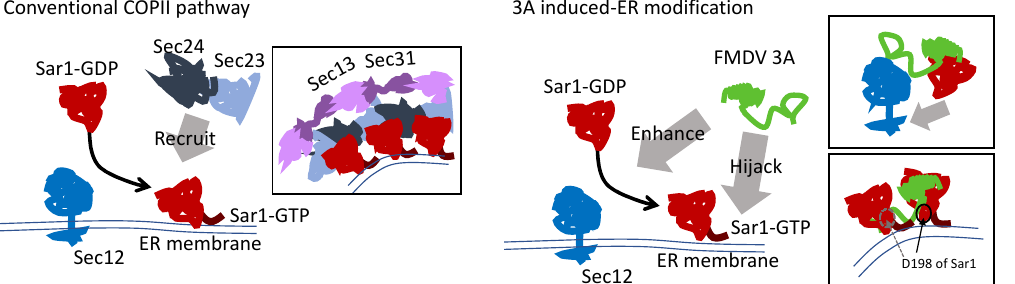
Figure 7. In the conventional COPII pathway, after activation by Sec12, Sar1 attaches to the ER membrane with the N-terminus, further recruiting the inner coat proteins Sec23 and Sec24. Sec24 recruits the COPII outer coat proteins Sec31 and Sec13 to bend the membrane into a vesicle-like structure. In FMDV 3A-expressing cells, we hypothesized that FMDV 3A modifies the ER into a vesicle-like structure, including Sar1 activation/enhancement and 3A—a Sar1–GTP intercalating complex. That is, 3A enhances Sar1 activation. Next, 3A intercalates into two active Sar1s to bend the membrane into vesicle-like structures.